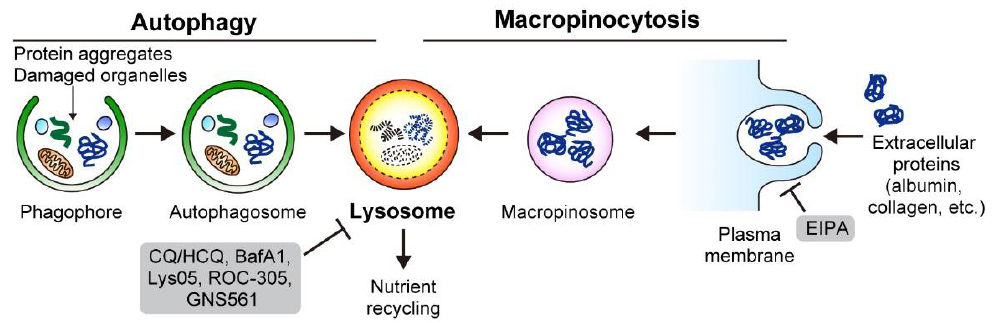
Figure 2. To thrive in the nutrient-deprived TME, PDAC relies on autophagy and macropinocytosis for intracellular nutrient recycling and extracellular nutrient scavenging. Autophagy targets the in- tracellular constituents, such as protein aggregates and damaged organelles, while macropinocyto- sis engulfs the extracellular nutrients via protrusion of the plasma membrane. Both autophagy and macropinocytosis depend on the lysosome for the degradation of their cargos and recycling of nu- trients. Inhibitors are shown in gray frames. Figure 2 is adapted from reference [41], the use of which mons.org/licenses/by/4.0/.